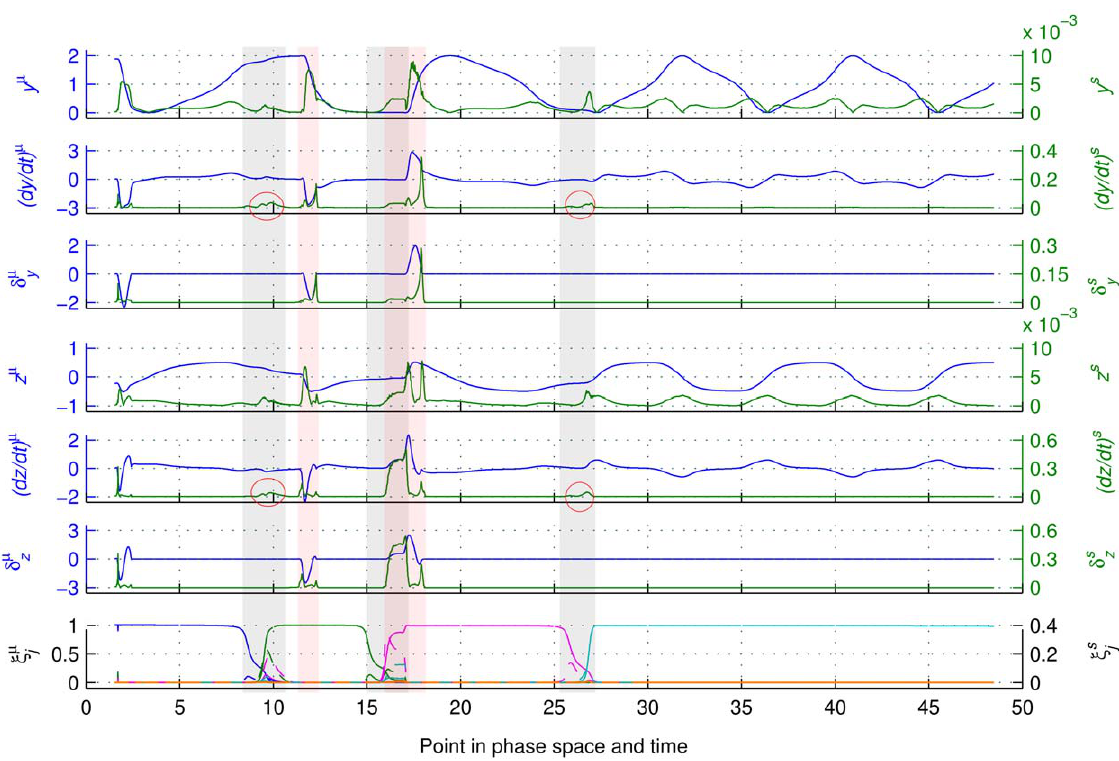
Figure 7. Phase space analysis. From top to bottom: means and standard deviations of y (denoted as y m and y s ), of dy / dt (( dy / dt ) m and ( dy / dt ) s ), of d y ( d y m and d ys ), of z ( z m and z s ), of dz / dt (( dz / dt ) m and ( dz / dt ) s ), of d z ( d z m and d zs ), and of { j j } ( j j m and j j s ). Colors, shadings and line styles are similar as in Figure 6. The effect of d -‘kicks’ on the architecture’s output is as evident as in Figure 6 (notice also that ( dy / dt ) s and ( dz / dt ) s are almost identical to d ys and d zs , respectively, in the segments with a d -‘kick’). The variability of { j j } ( j js ) that signals mode transitions, now has a significant effect on standard deviations of dy / dt and dz / dt that approximate the phase flow. This effect cannot be identified unambiguously in the variability of the trajectory in the phase space ( y s and z s ). At the first transition, the d -‘kick’ variability follows that of the { j j }, and their effects are easily separable. Instead, at the second transition, the mean of the { j j } modulates the standard deviation of d z and thereby the one of dz / dt as well (because of their overlapping in the data set). At the third transition no d -‘kick’ is involved; however, there is still a significant increase in ( dy / dt ) s and ( dz / dt ) s due to the increase in j j s .